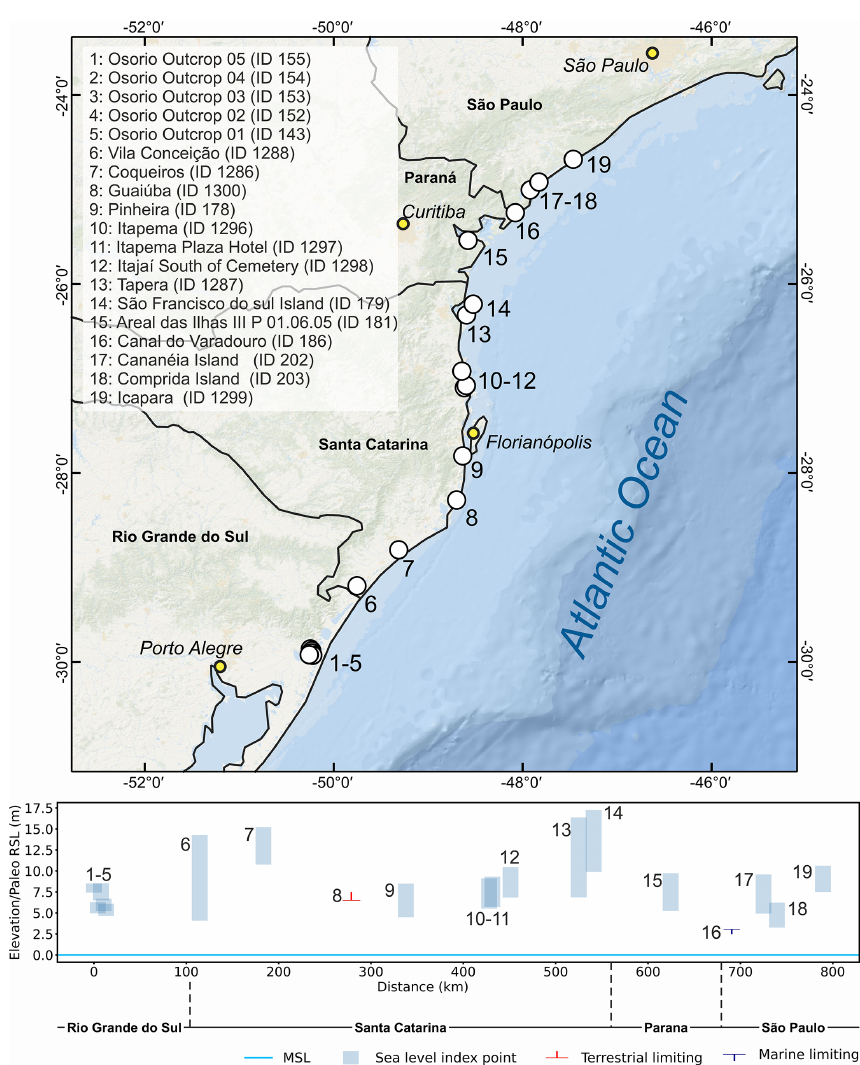
Figure 3. Last interglacial sea-level data in the Brazilian states of Rio Grande do Sul, Santa Catarina, Paraná, and São Paulo. Upper panel: map of sites. Basemap: Esri, Garmin, GEBCO, NOAA NGDC (now NCEI), and other contributors. Lower panel: distance–elevation plot.